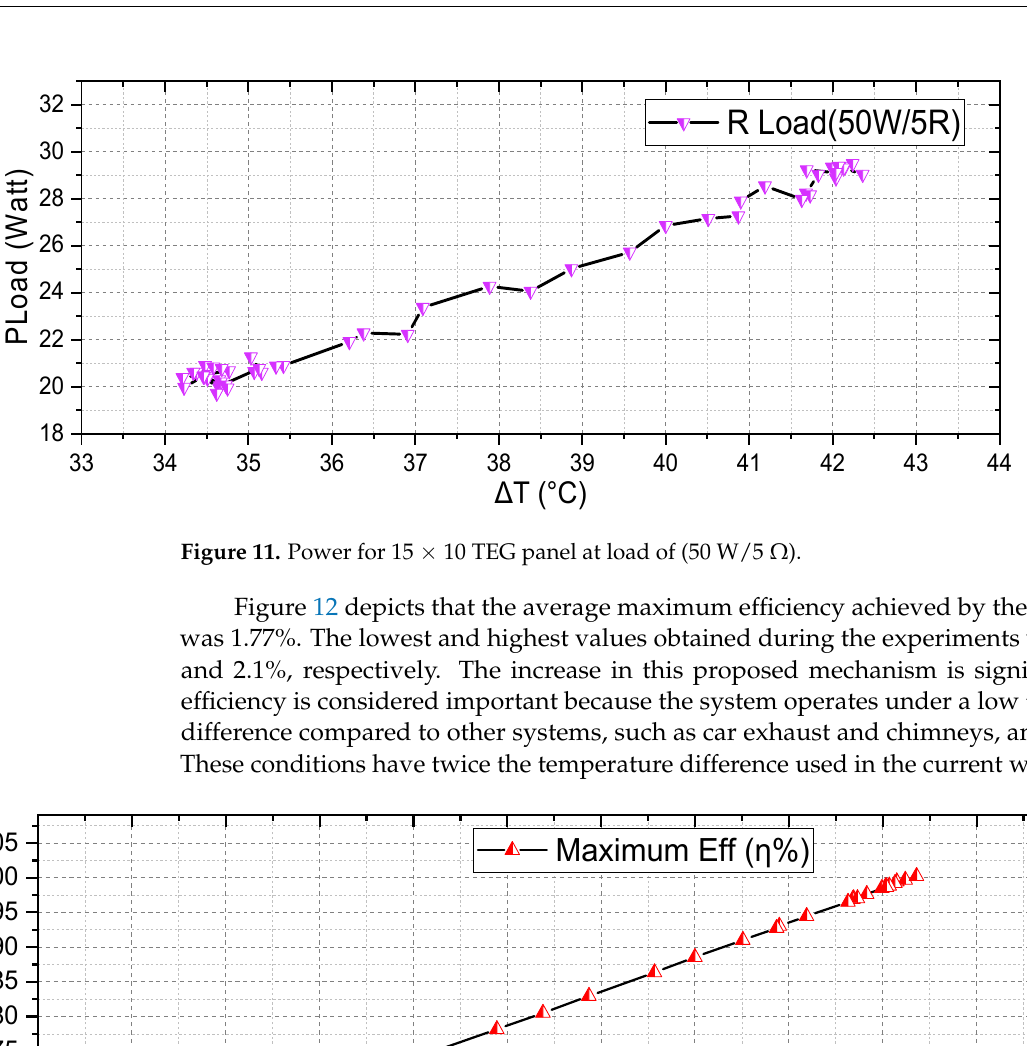
Figure 10. Voltage for 15 × 10 TEG panel systems.